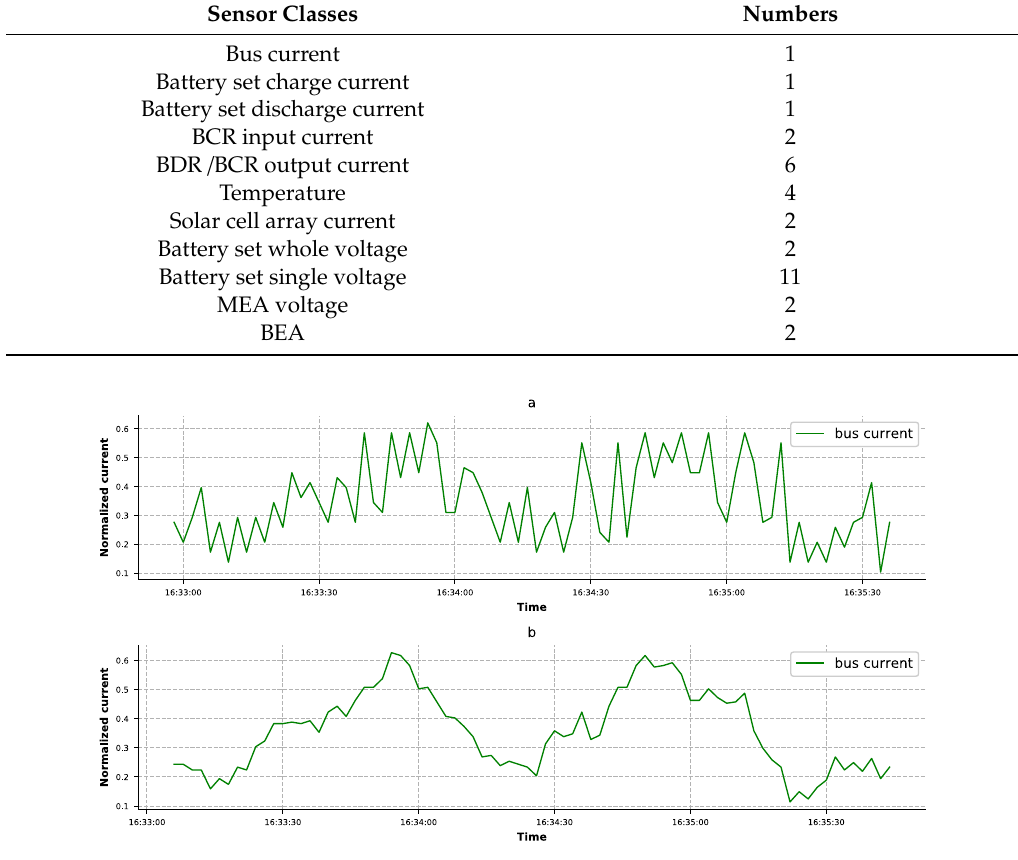
Figure 4. Comparison of the original bus current and the one processed by the moving-average method. ( a ) The original bus current. ( b ) The bus current processed by the moving-average